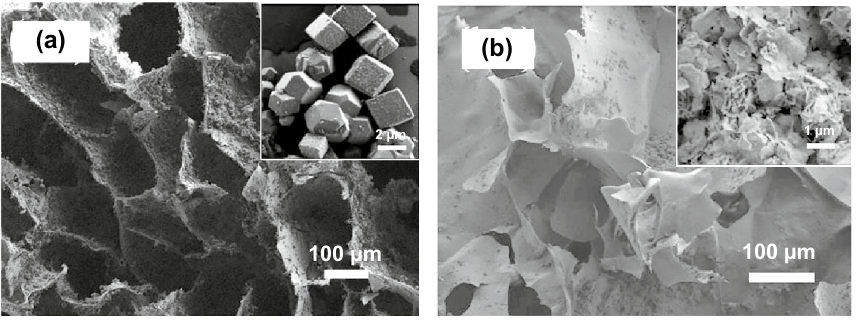
Fig. 6 SEM images of a ZIF-9@CA and pure ZIF-9 inset, and b ZIF-12@CA and pure ZIF-12 inset. Reprinted with permission from Ref. [75]. Copyright 2018 Elsevier